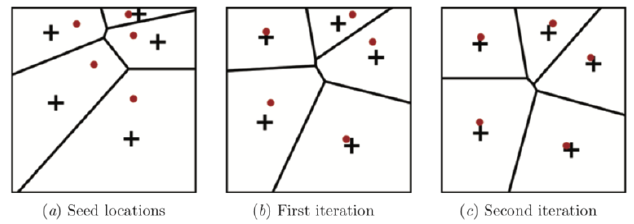
Figure 5. Mesh smoothing using Lloyd iterations where seed points (red) move towards cell centroids (black +) with each iteration and the Voronoi diagram is recomputed (source: Wikipedia).